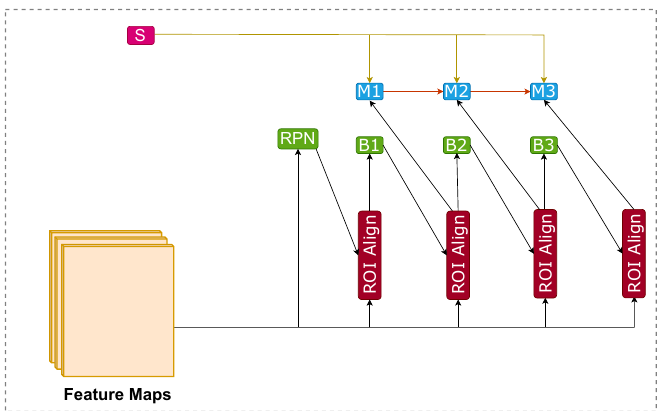
Figure 3. Explained architecture of the Hybrid Task Cascade Network. This network utilizes three box and mask heads in a cascading architecture to produce accurate